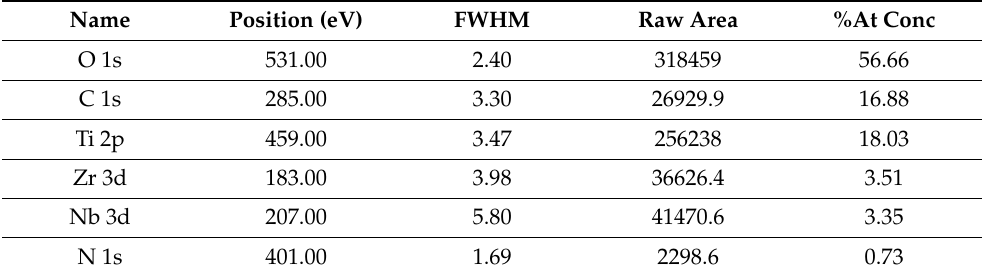
Table 3. Binding energies of elements and their relative atom concentration from XPS widescan